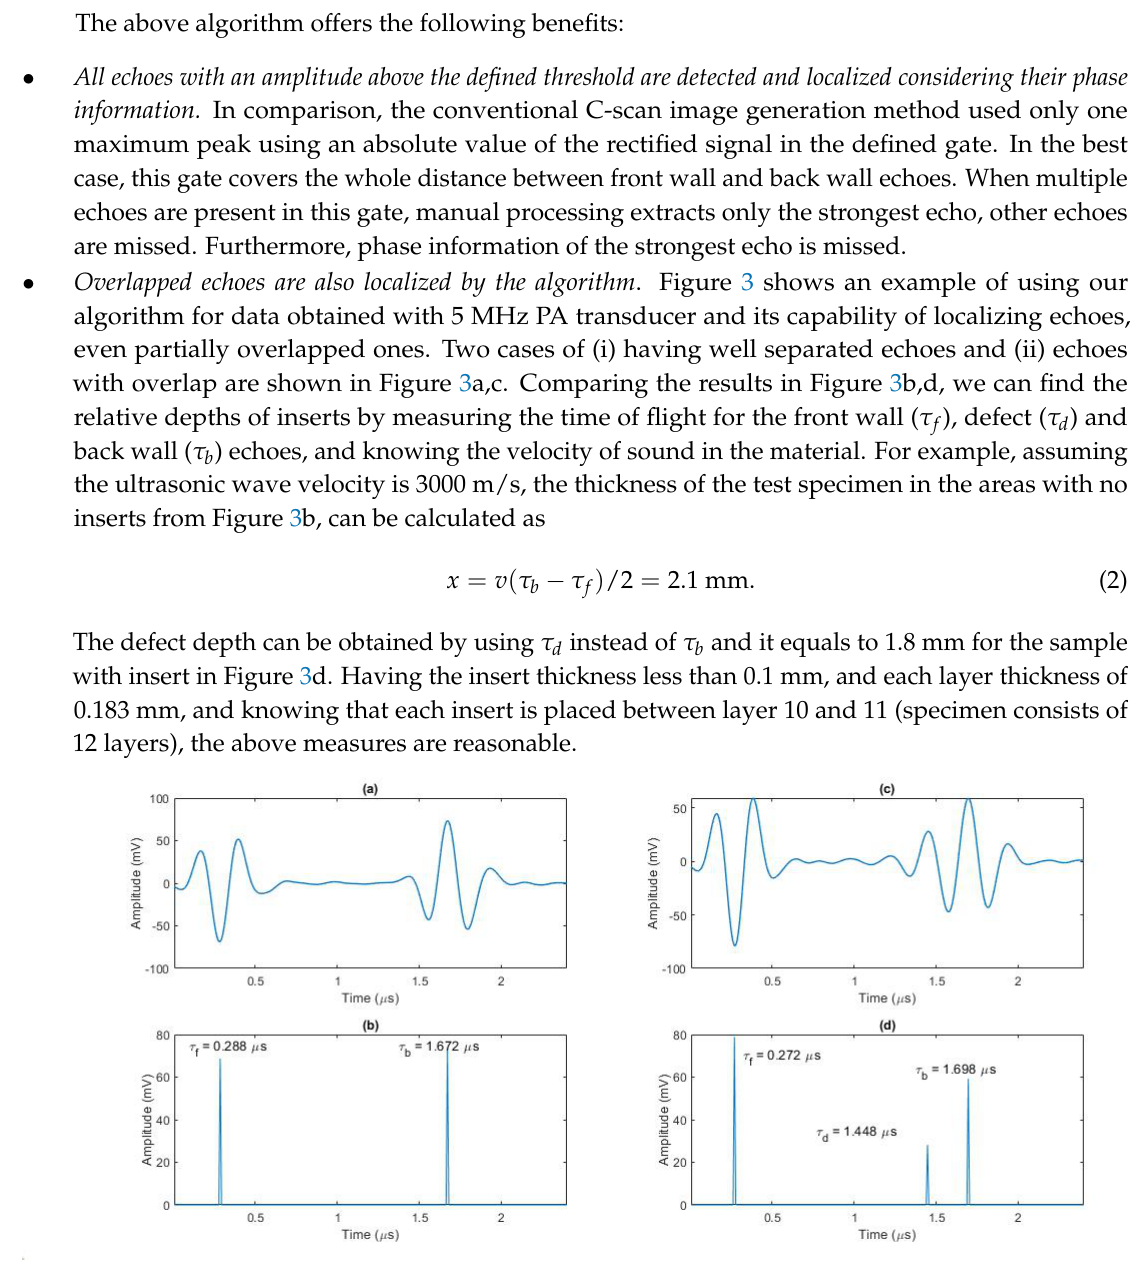
Figure 3. Two different A-scans using 5 MHz PA transducer: ( a ) one at non-defective location, and ( c ) an A-scan at a location with defect close to back wall; localisation results of the baseline localisation algorithm for ( a , c ) are shown in ( b , d ) respectively, providing time-of-flight for the front wall ( τ f ), defect ( τ d ) and back wall ( τ b )